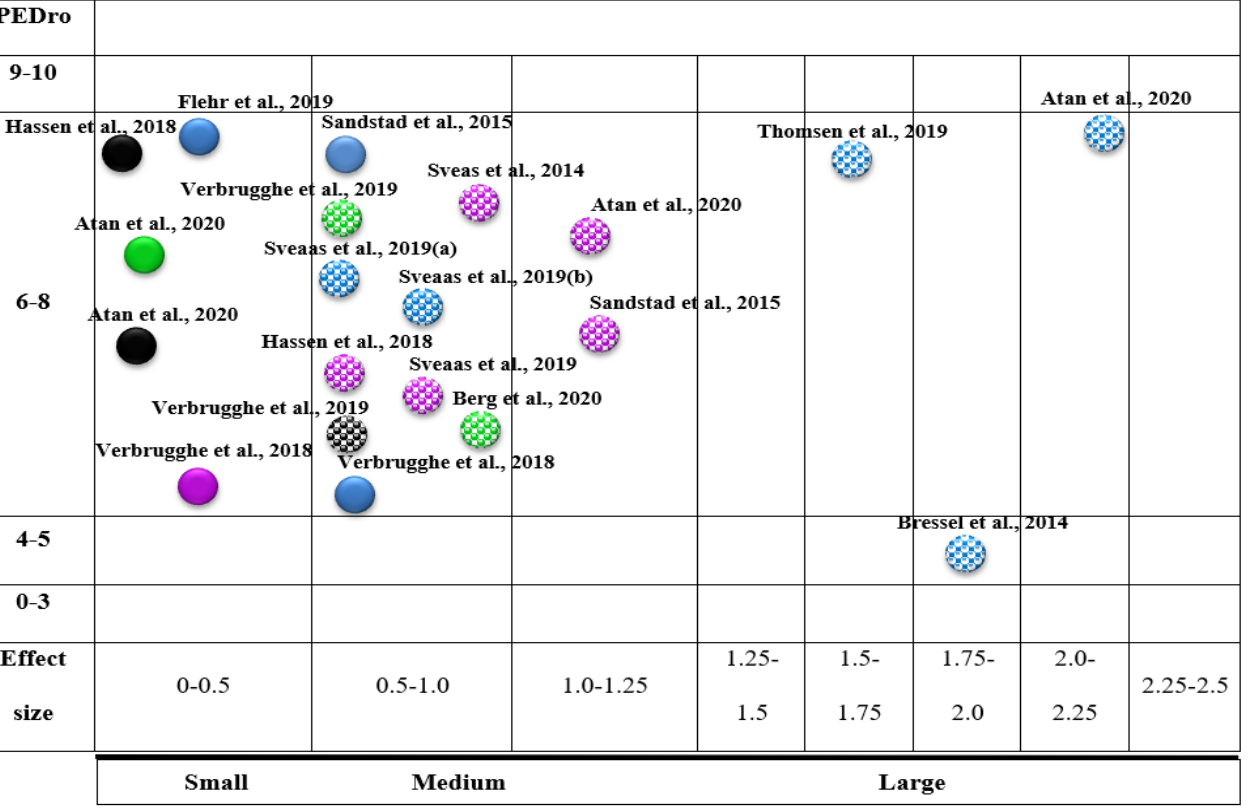
Figure 3. A mapping of included studies based on effect size. Blue, Pain intensity; Violet, VO 2 max ; Green, Disability; Black, Quality of Life. Bubbles marked with white dots indicate statistically sig- nificant differences ( p < 0 .05).